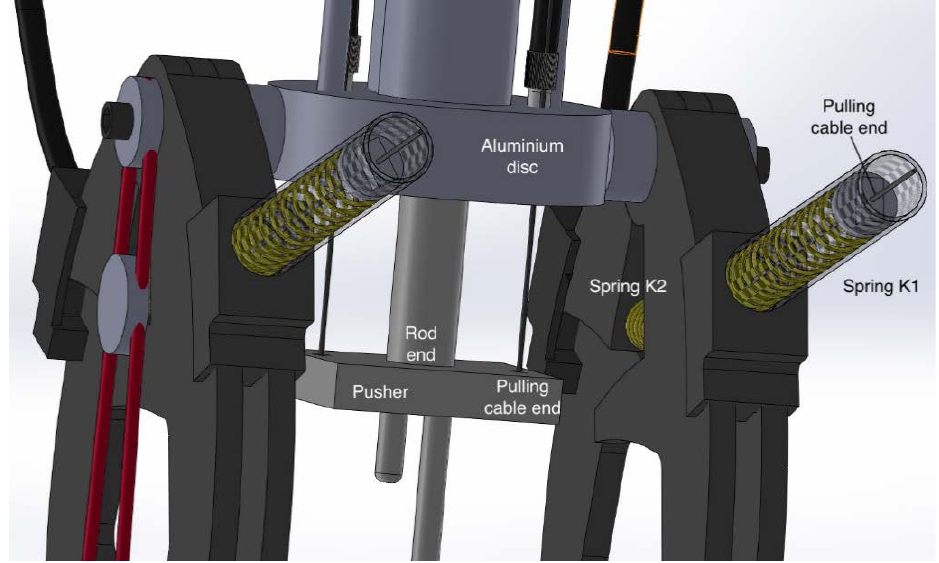
Figure 4. Detailed view of the attachment of the clamps to the linear actuator.